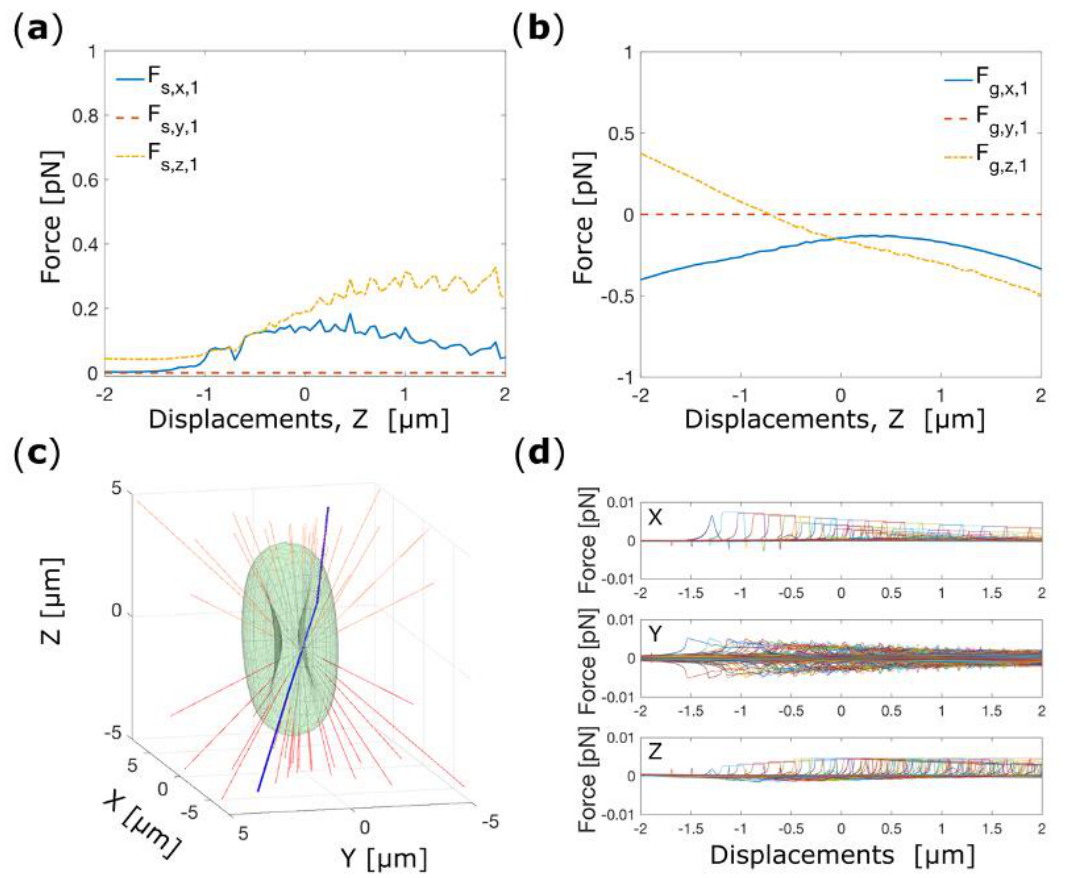
Figure 2. ( a ) Cartesian component of the scattering force as a function of the translation along the z -axis. ( b ) Cartesian components of the gradient force acting on the center of mass of the RBC as a function of the cell’s displacements along the z -axis. ( c ) Ray traces for a cell placed in the folded position and located at ( x eq,1 , y eq,1 , z eq1 ). The blue ray indicates the light ray that exerts the highest force on the cell. ( d ) Total optical force exerted by each single light ray on the center of mass of the